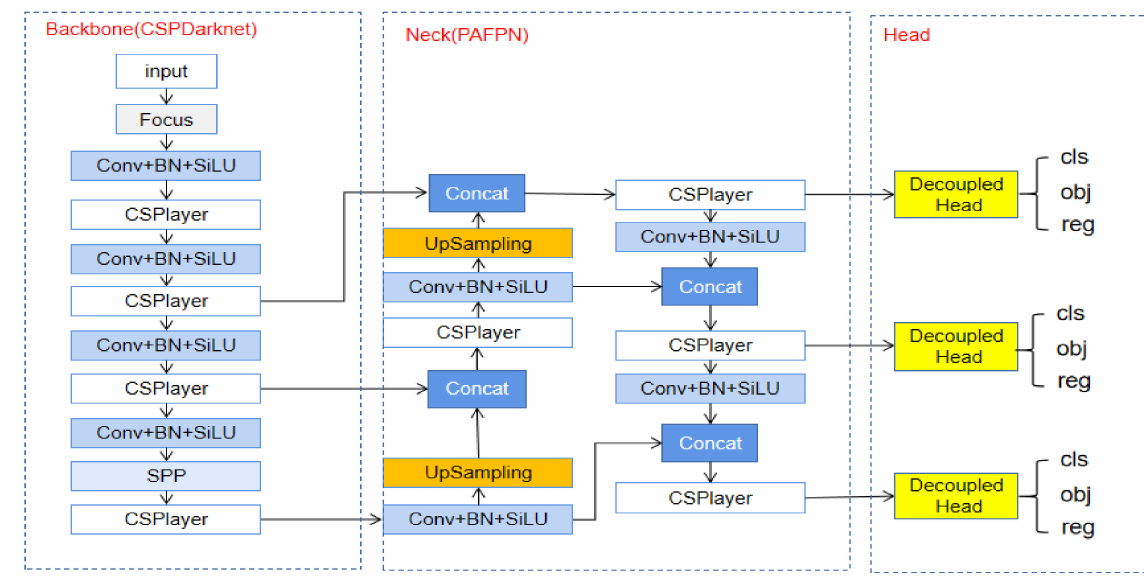
Figure 1. Structure of